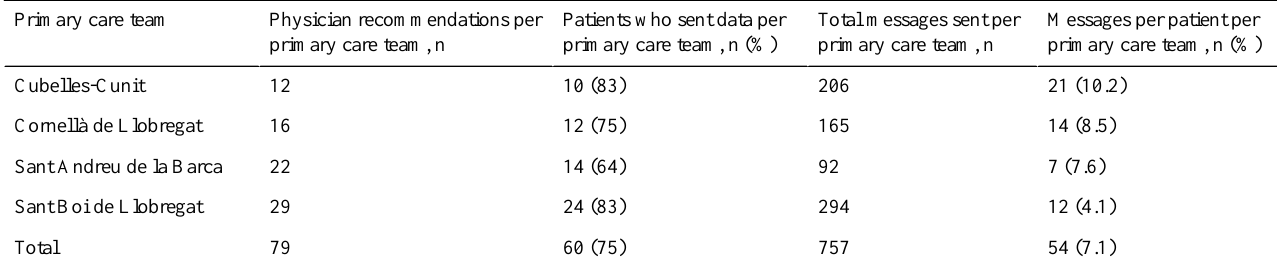
Table 3. Physician recommendations, messages, and data-uploads sent per primary care team.